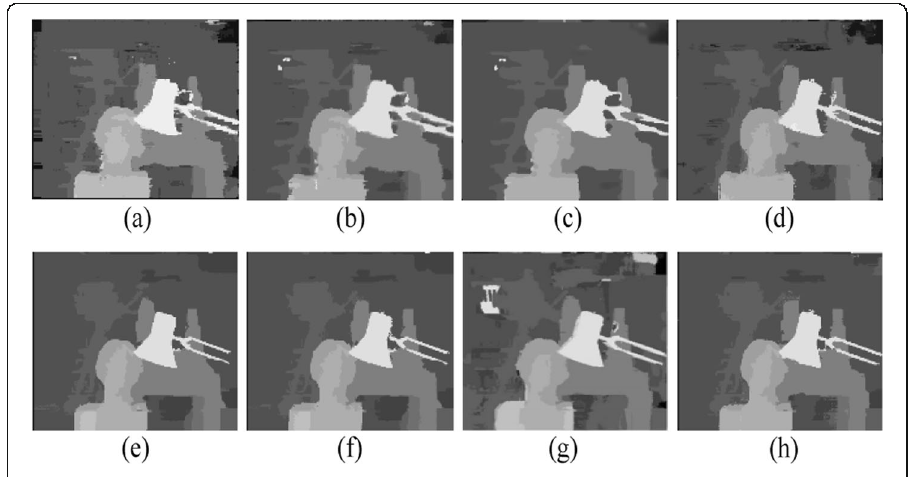
Fig. 17 Estimated disparity maps of Tsukuba achieved by a Kuo et al. [27], b Kuo [28], c Hsieh [29], d Sun [31], e ASW [21], f S-ASW [23], g LF-SM [36], and h the proposed methods